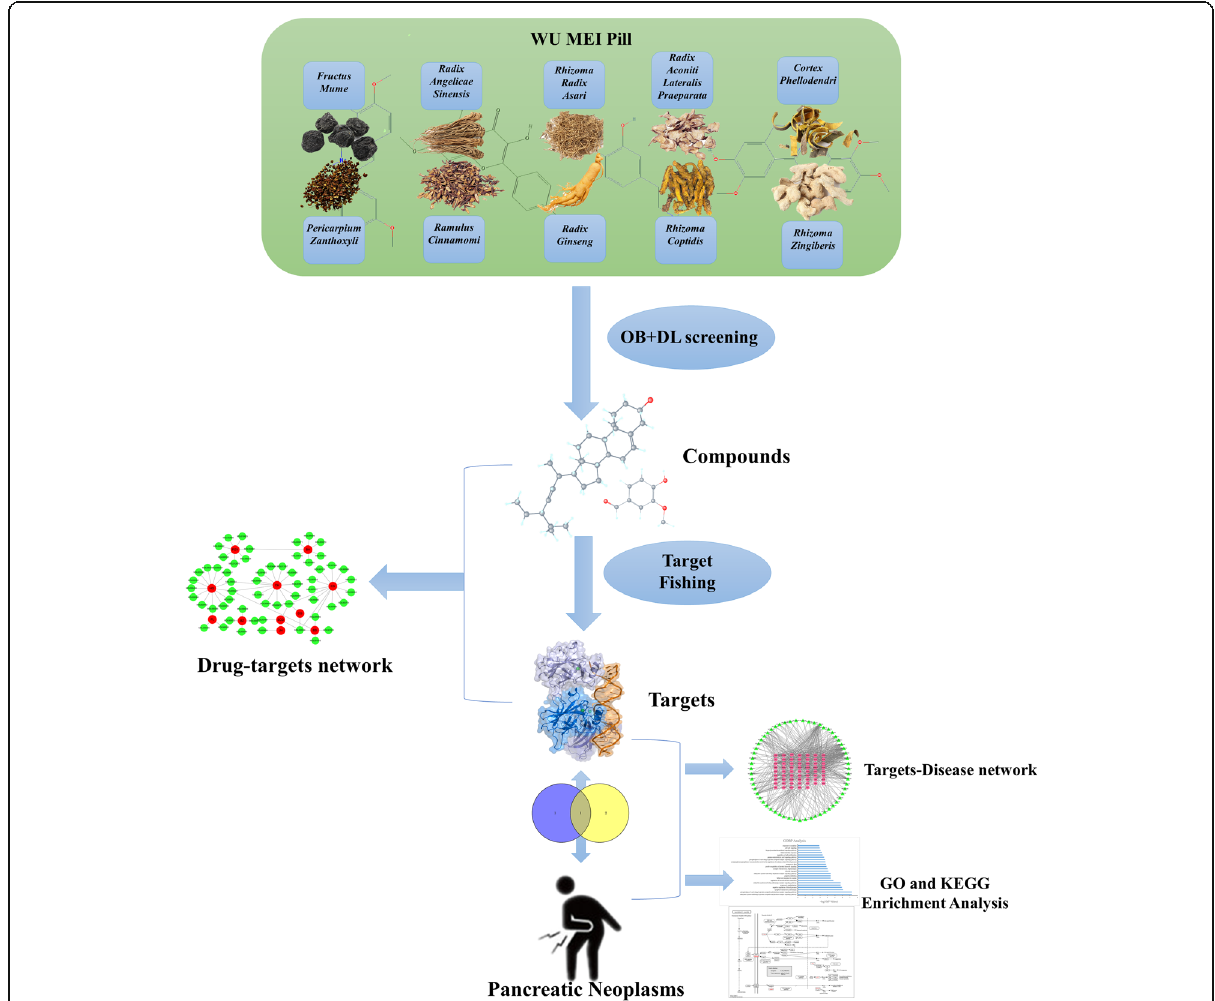
Fig. 1 The whole framework based on an integration strategy of network